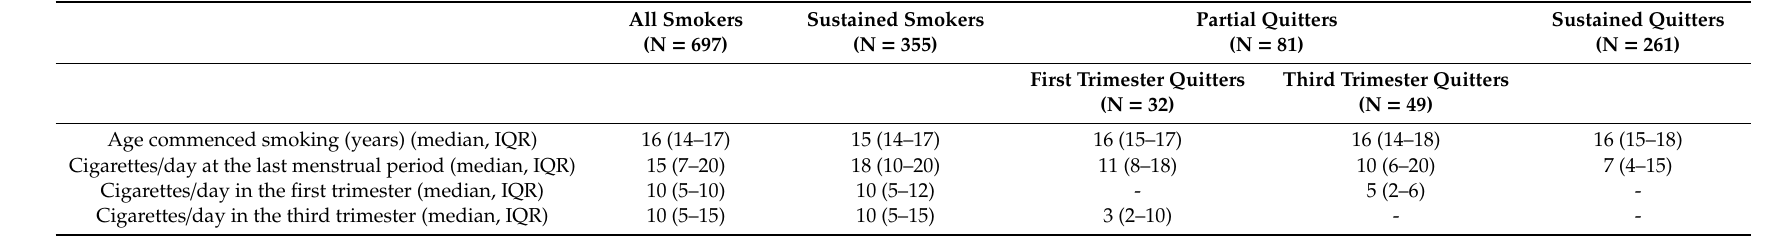
Results expressed as median (interquartile range). Abbreviation: IQR interquartile